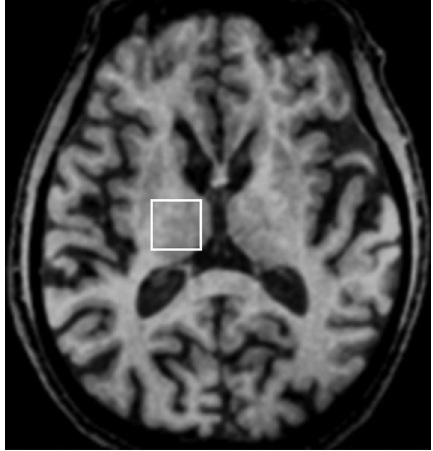
Figure 1. Voxel placement in the thalamus.